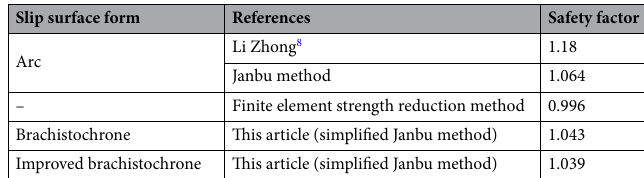
Table 3. Comparison of safety factors obtained by different